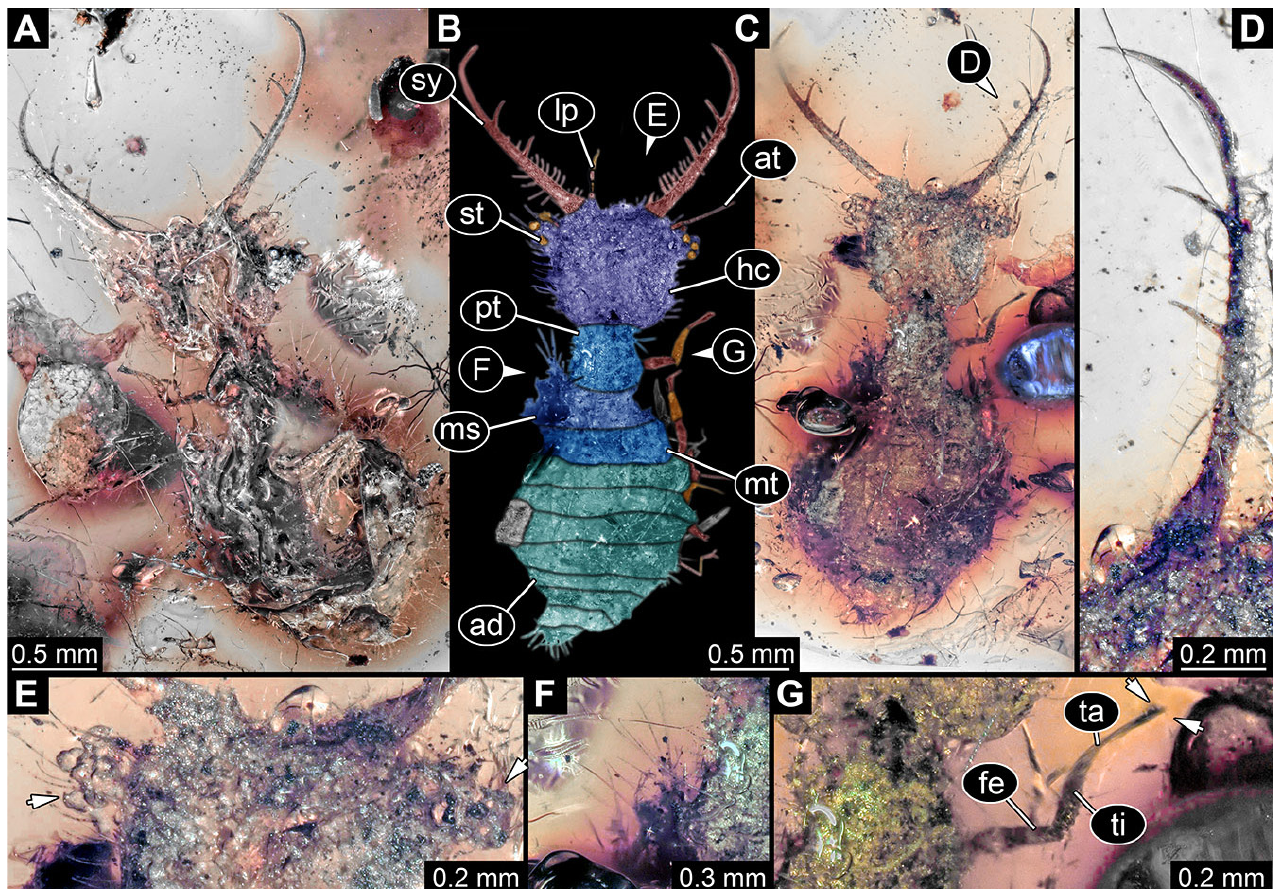
Figure 25. Fossil owllion larva, specimen 3238 (PED 0320), Cretaceous Kachin amber, Myanmar. ( A ) Overview, ventral. ( B ) Color-marked version of ( C ). ( C ) Overview, dorsal. ( D ) Close-up on stylet. ( E ) Close-up on head capsule with fields of stemmata (arrows). ( F ) Close-up on dorsal process. ( G ) Close-up on locomotory appendage with claws (arrows). Abbreviations: ad = abdomen; at = antenna; fe = femur; hc = head capsule; lp = labial palp; ms = mesothorax; mt = metathorax; pt = prothorax; st = stemmata; sy = stylet; ta = tarsus; ti = tibia. 28. Specimen 3239 (PED 0378) is preserved in Cretaceous Kachin amber, Myanmar. Spec-